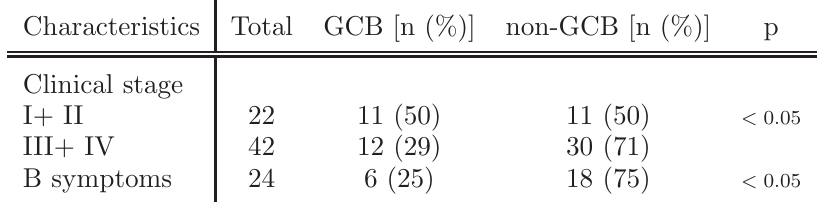
Table 2 Patient characteristics and immunohistochemistry classification.